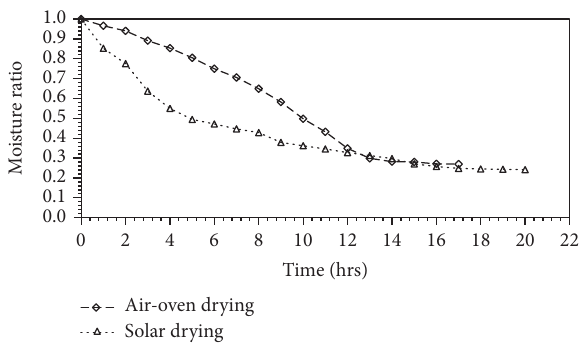
Figure 1: Variation of moisture ratio in solar- and air-oven-dried shrimp